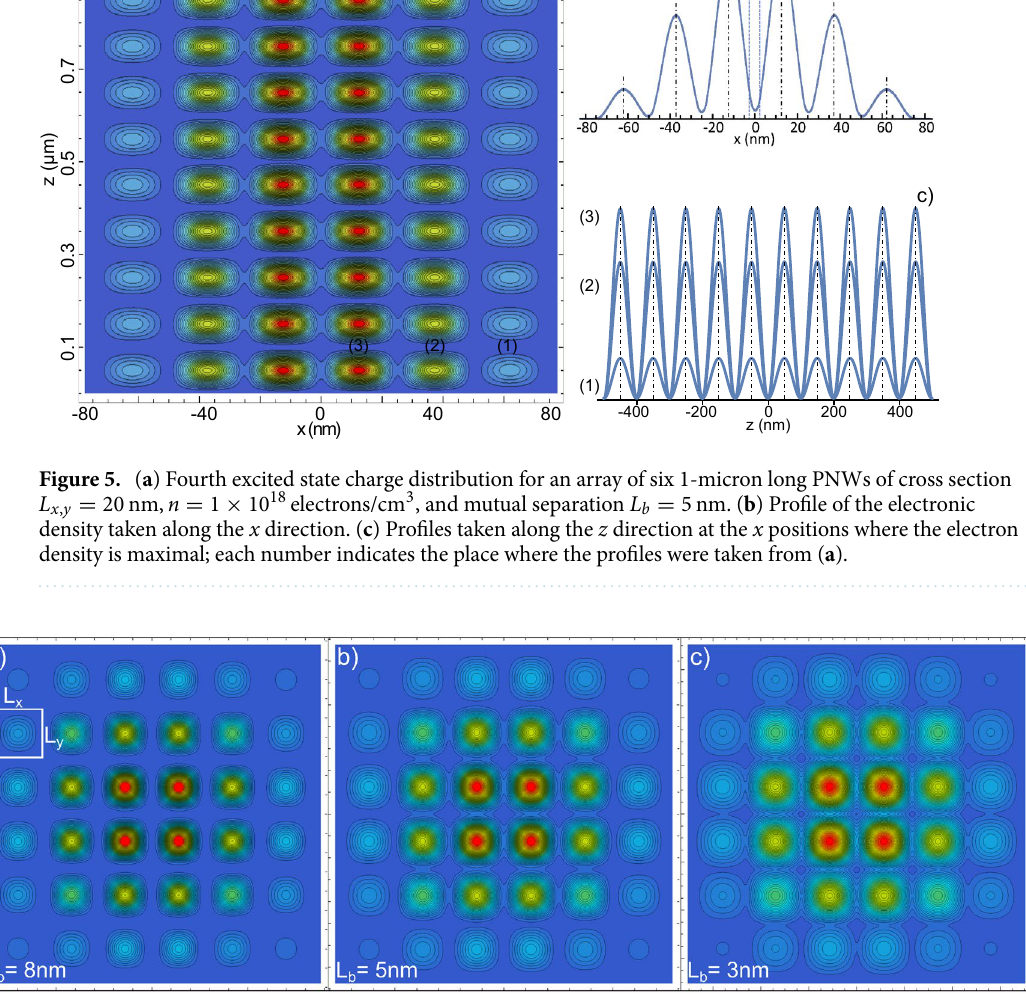
Figure 6. x – y projections of the ground state electron configuration in 6 The NWs mutual separation L b is modified from 8 to 3 nm to observe the gradual transition to a strongly interconnected 2D distribution. The distributions are obtained by considering only the x and y wave function components. In ( a ), the x – y boundary of one of the NWs is outlined as a visual